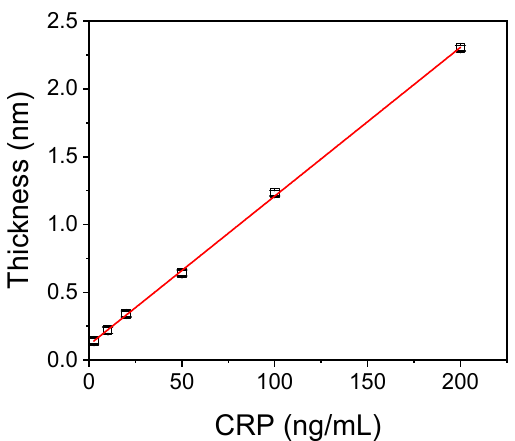
Figure 4. Typical linearized CRP calibration curve obtained with the WLRS bioanalytical system. Each point is the mean value of four replicate measurements ±SD.